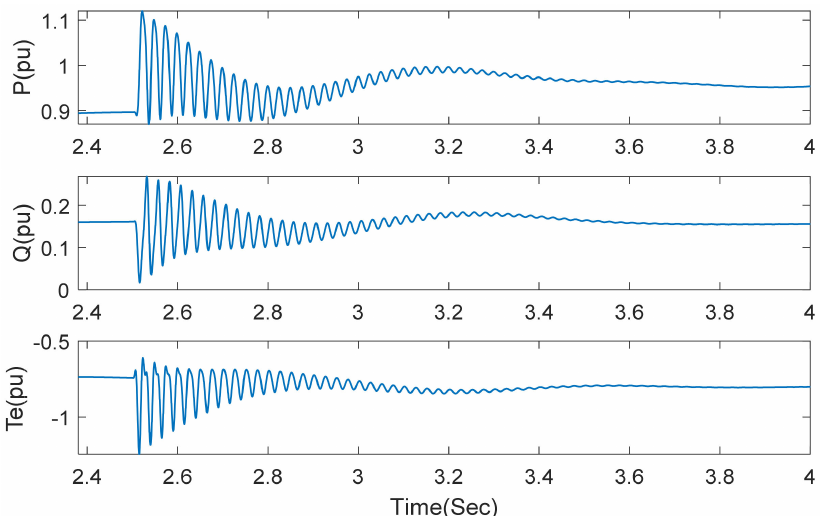
Figure 3. Transient responses of active power, reactive power, and electromagnetic torque after 40% series compensation is switched.